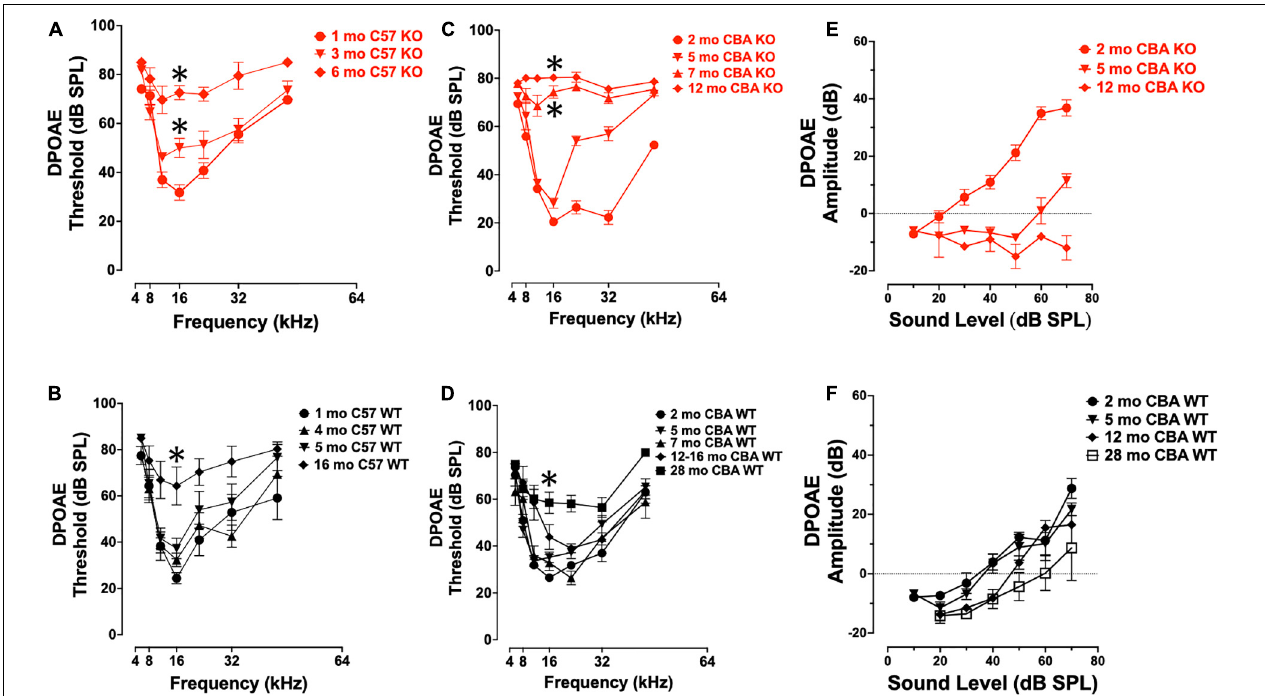
FIGURE 2 | Ocm KO mice show progressive elevation in distortion product otoacoustic emission (DPOAE) thresholds. (A,B) Mean ± SEM DPOAE thresholds as a function of f 2 frequency for 1 – 6 mo C57 KO ( A , n = 23) and 1 – 16 mo WT mice ( B , n = 33). Significant ( p < 0.05) total threshold shifts were observed when comparing from 1 mo to all other ages and 3 – 6 mo ages of C57 KO animals. Total threshold shifts were significantly different between 5 and 15–16 mo in C57 WT. (C,D) Mean ± SEM DPOAE thresholds as a function of f 2 frequency for CBA mice. (C) DPOAE thresholds from 2 to 12 mo CBA KO ( n = 31) animals and (D) 2 – 28 mo WT ( n = 49) animals. Total threshold shifts were significantly ( p < 0.0001) different between 2 and 5 mo, and between 5 and 7 mo CBA WT. Total threshold shifts were significantly ( p < 0.01) different between 7 and 12 – 16 mo, and between 12 – 16 mo and 28 mo CBA KO. (E,F) Mean ± SEM DPOAE input/output functions from panels (E) KO and (F) WT animals. Asterisks represent significance ( p < 0.05) from 1 to 2 mo at 16 kHz.